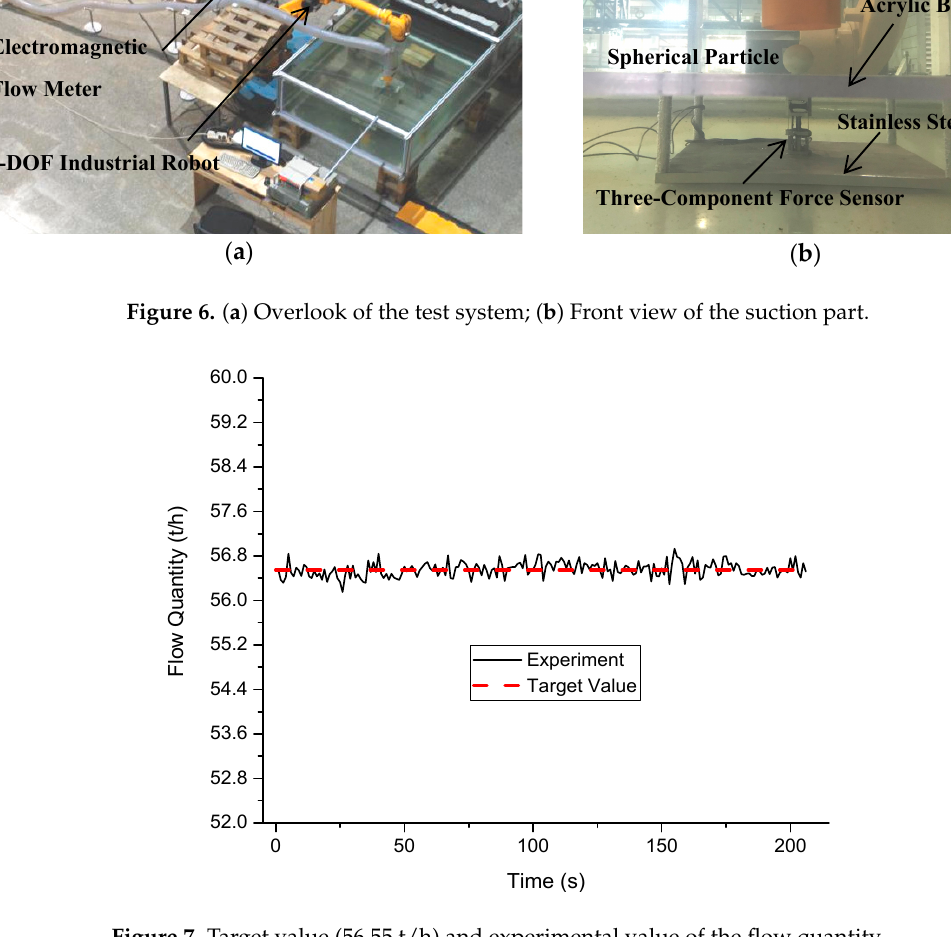
Figure 6. ( a ) Overlook of the test system; ( b ) Front view of the suction part.